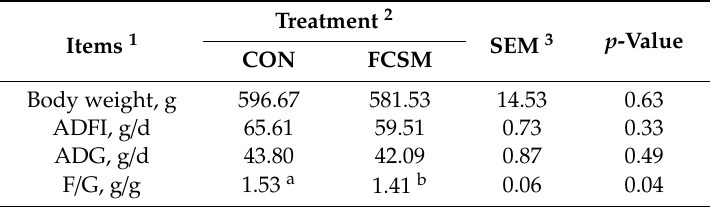
Table 3. E ff ect of FCSM on the growth performance of broiler.